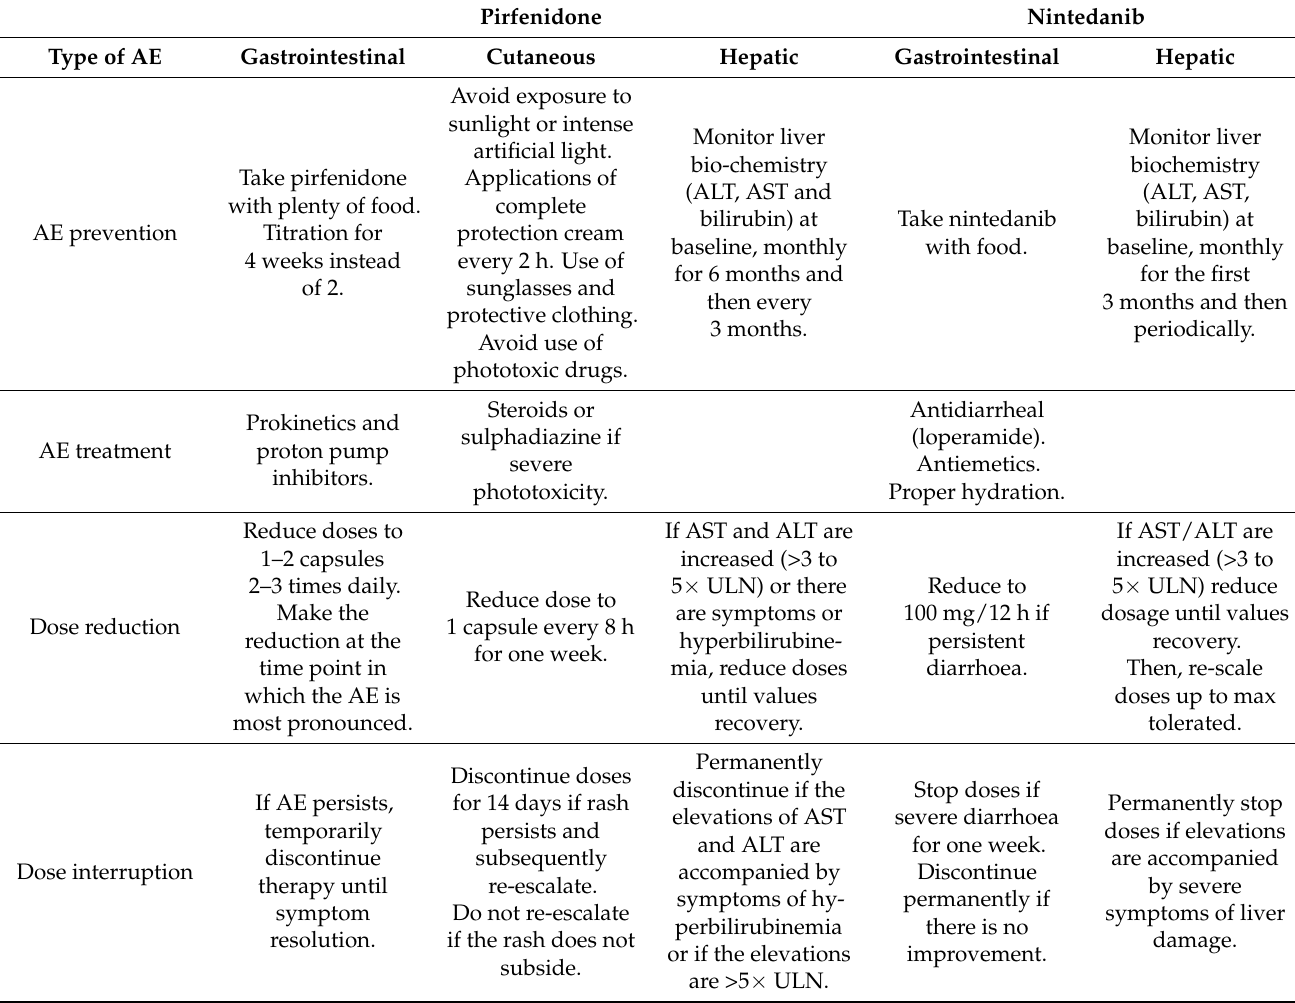
Table 3. Strategy for the prevention and management of adverse events related to antifibrotic